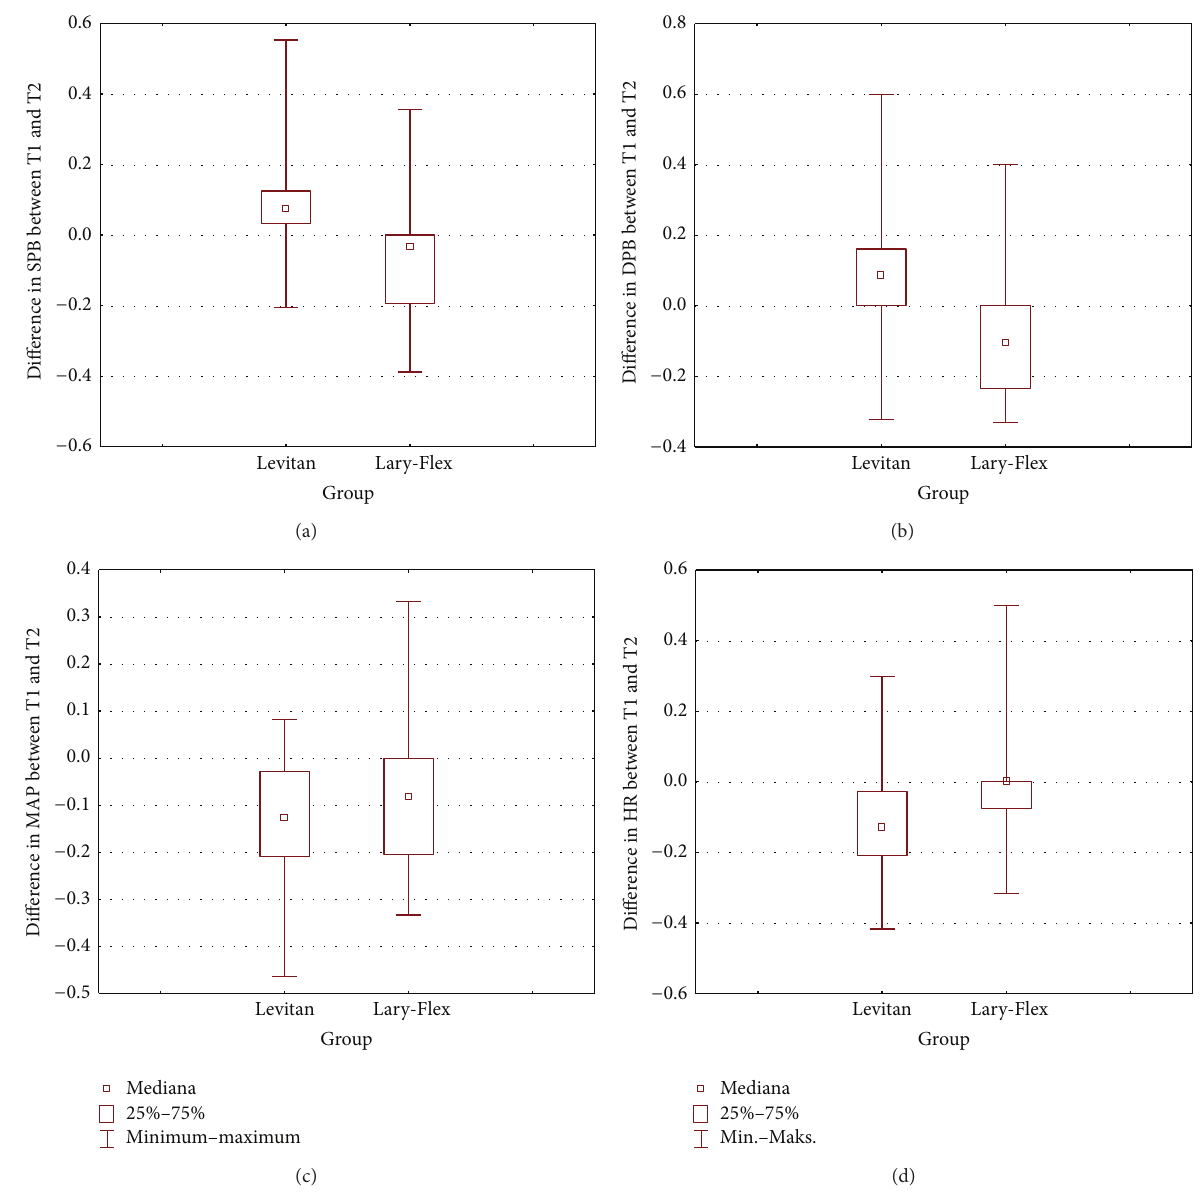
Figure 7: Differences in cardiovascular parameters between time points [%]. T1: preintubation (postinduction), T2: